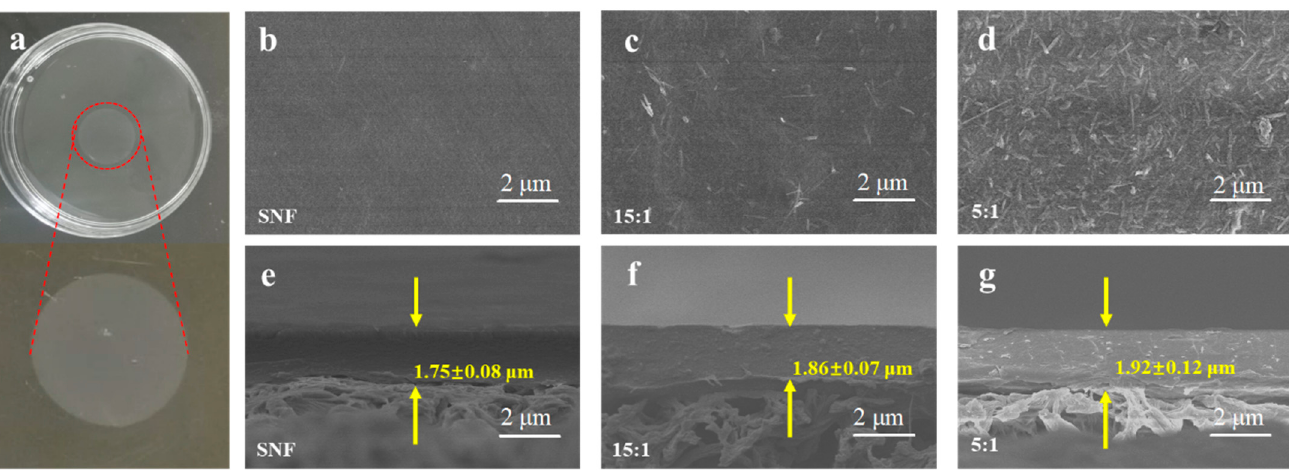
Figure 4. Visual appearance and structural characterization of the obtained membranes: ( a ) photos of SNF-PGS-G composite membranes with a transparent and uniform surface; ( b – g ) surface and cross-sectional scanning electron microscope (SEM) images of the SNF-G, SNF-PGS-G (15:1), and SNF-PGS-G (5:1) membranes.